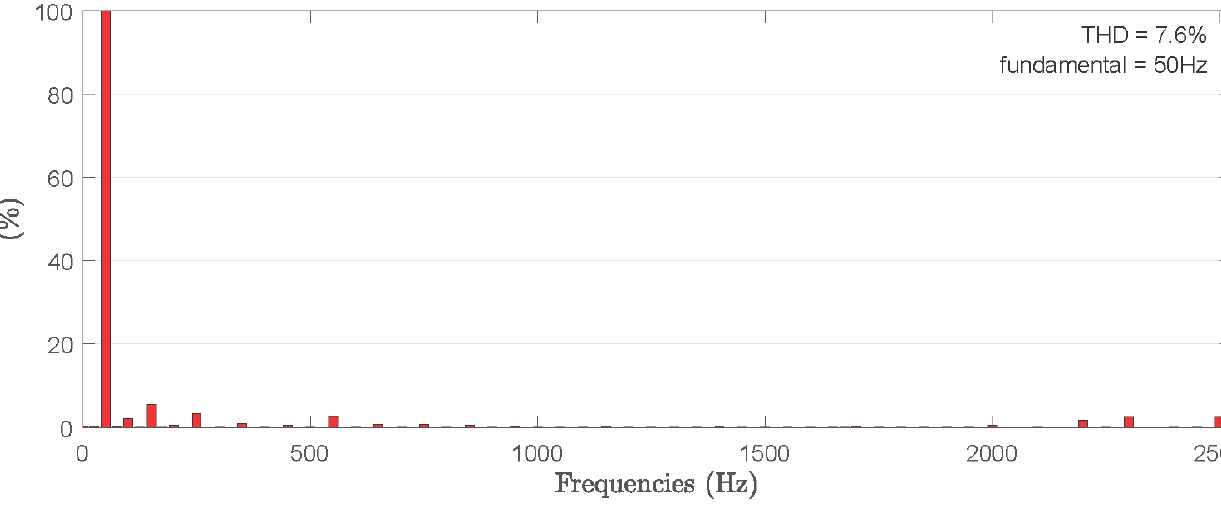
Figure 19. Current THD results using the grid analyzer.